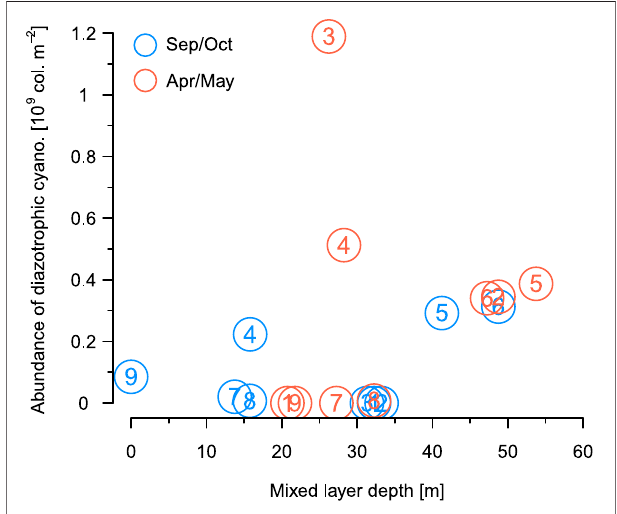
FIGURE 6 | The depth-integrated abundance of diazotrophic cyanobacteria colonies for the 9 sampling stations plotted as a function of surface mixed layer depth for the end of the dry season (blue: September/ October 2017) and the end of the rainy season (red: April/May 2018).